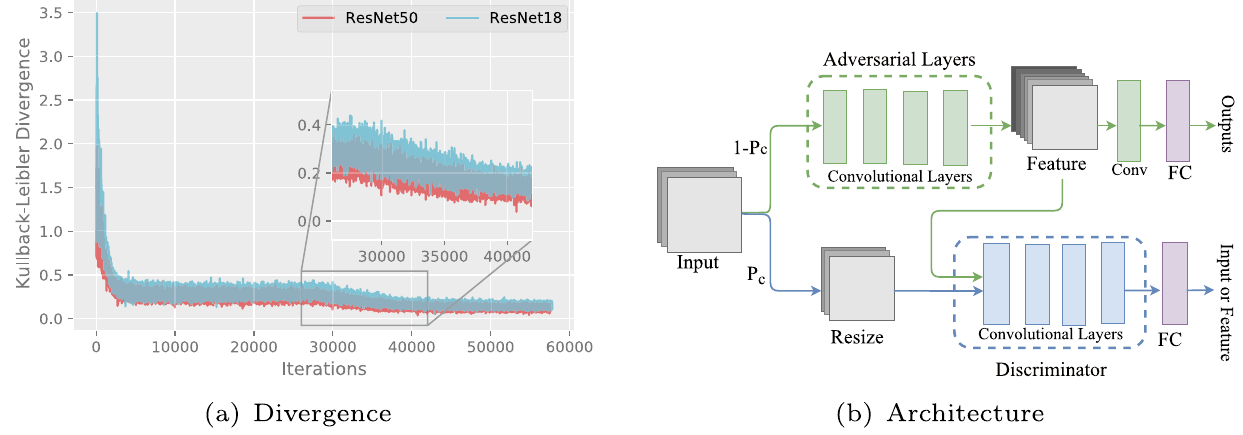
Fig. 2 The Kullback–Leibler curve during the training and the proposed architecture. The left figure shows the Kullback–Leibler divergence between the input data and the hidden feature, and the figure at the right is the architecture of the proposed